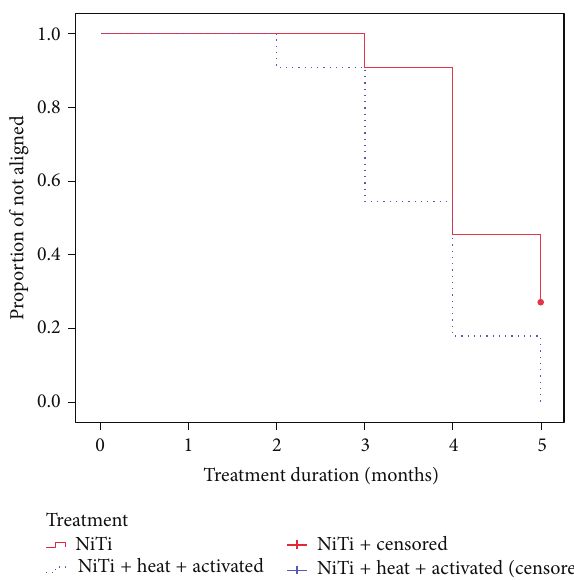
Figure1:Kaplan-Meiersurvivalestimates.Proportionoftreatments not completed according to arch wire